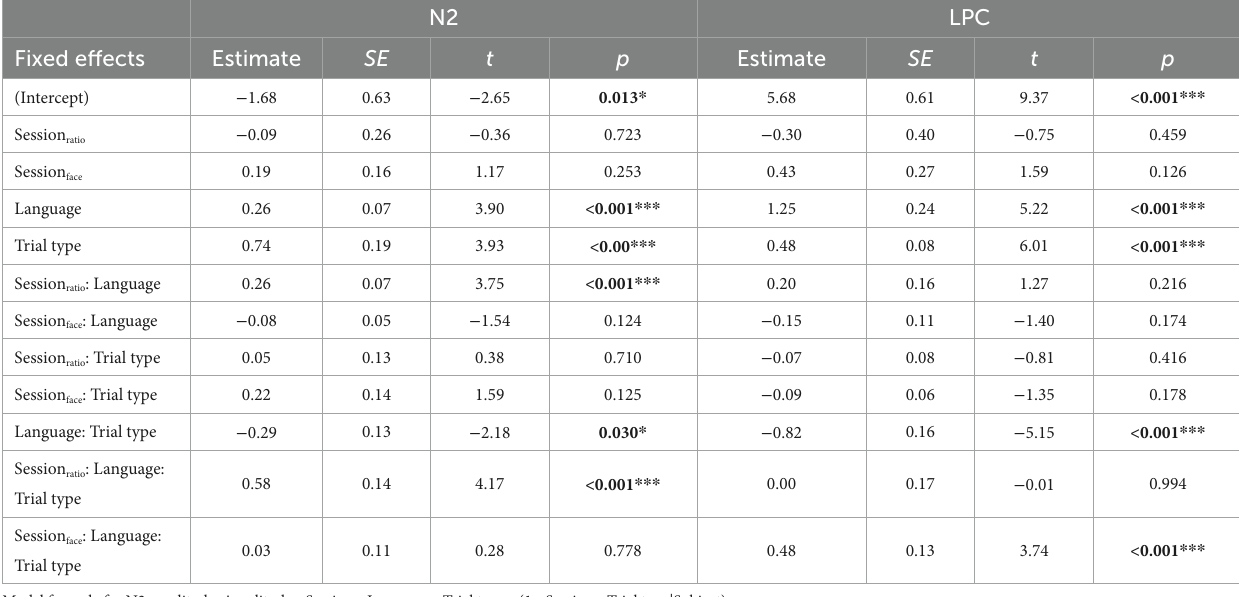
TABLE 3 Mixed effects model for N2 and LPC. N2